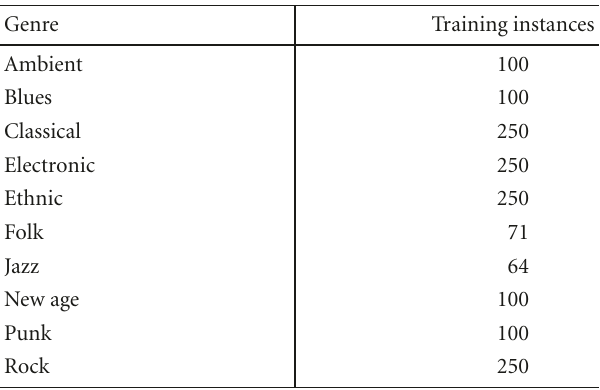
Table 5: Average number of closest songs with the same artist.